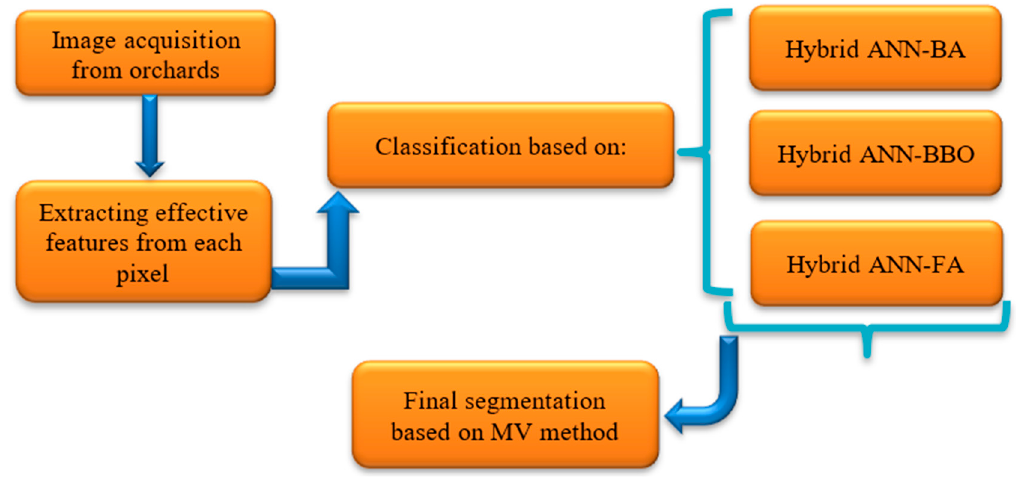
Figure 5. The final flowchart of the different stages of the proposed system in this article.